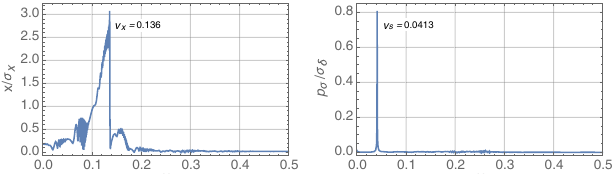
FIG. 14. Spectrum of horizontal (left) and longitudinal (right) motion from tracking corresponding to initial condition x ¼ 95 . 5 σ , and adjusted longitudinal initial conditions. The x longitudinal harmonic at double betatron frequency is too small to be